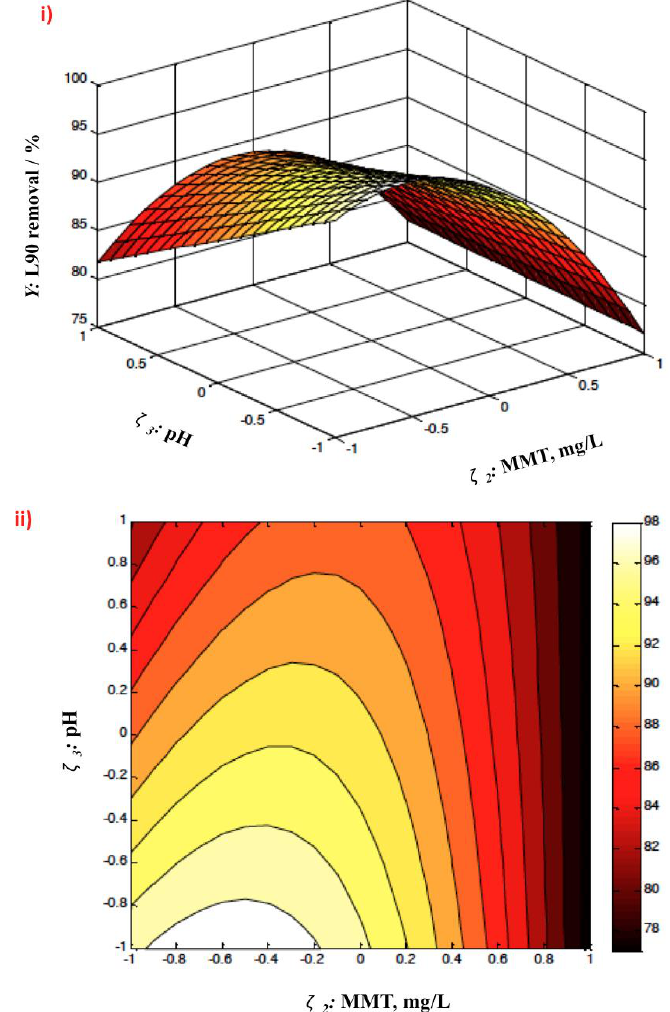
Figure 10. Factorial model design ’s optimal results: ( i ) 3-D surface plot and ( ii ) 2-D contour plot of the ( Y ) response and the interacting effect of Montmorillonite catalyst concentration and pH.